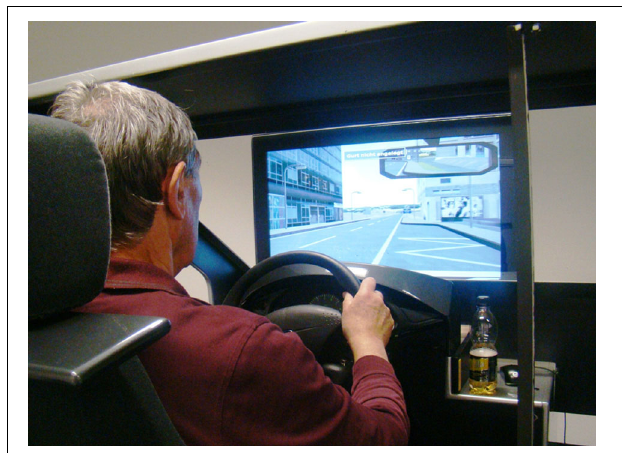
FIGURE 1 | Still photo of the used driving simulator.